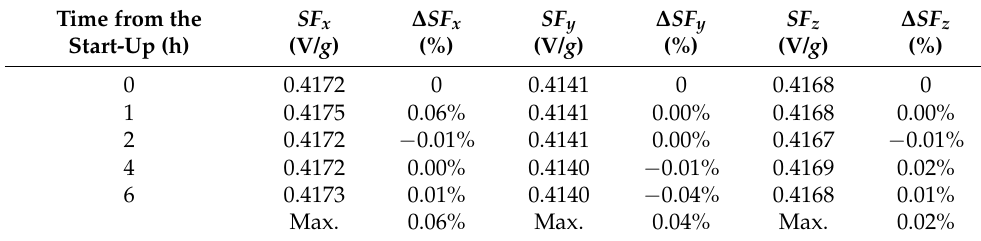
Table 7. Scale factor variations within six